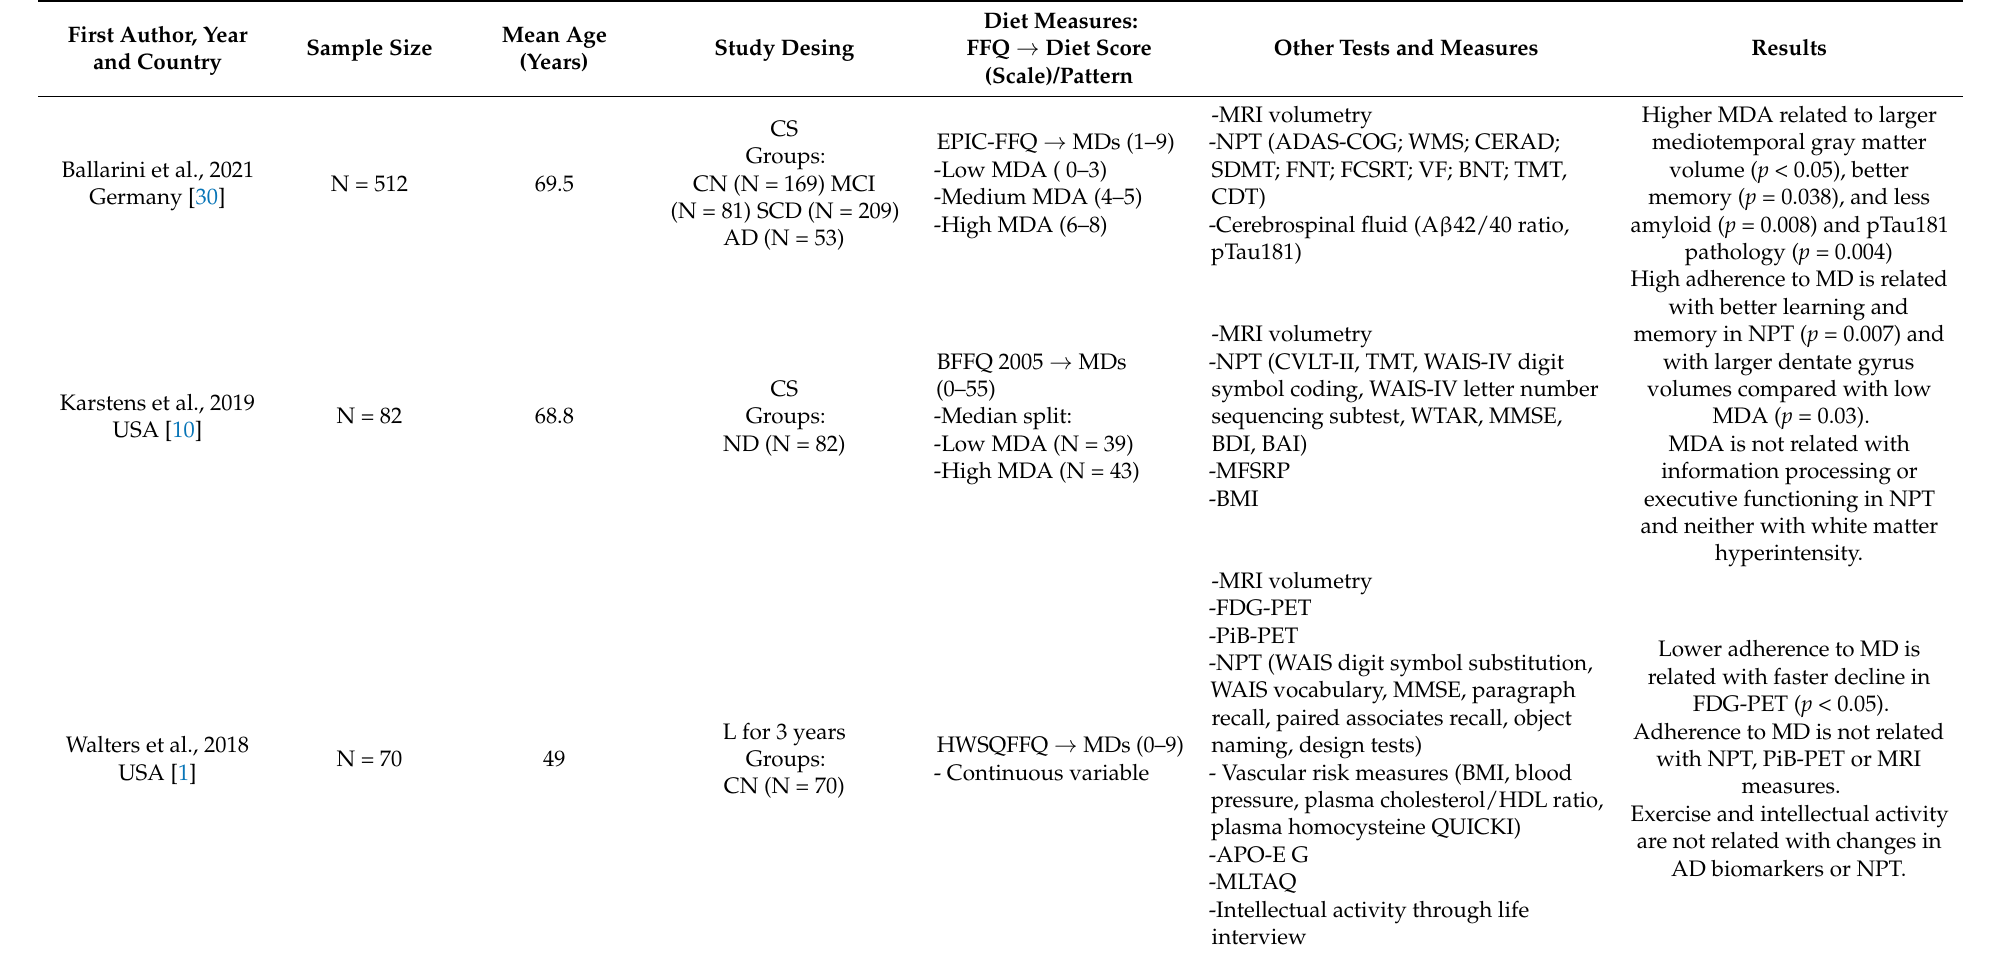
Table 1. Characteristics of studies included in qualitative analysis of association of Mediterranean diet with Alzheimer’s disease and mild cognitive